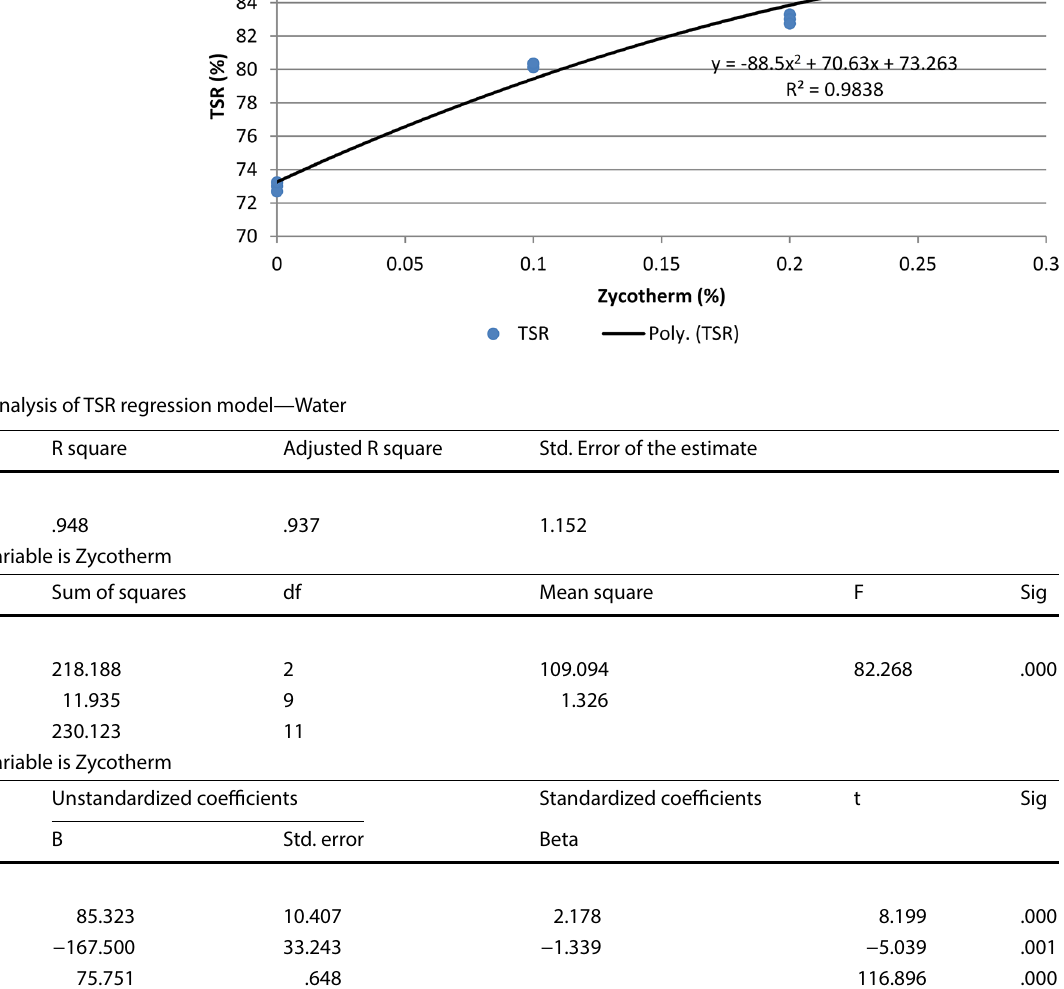
Fig. 13 Regression model of TSR for samples saturated with potassium acetate solution